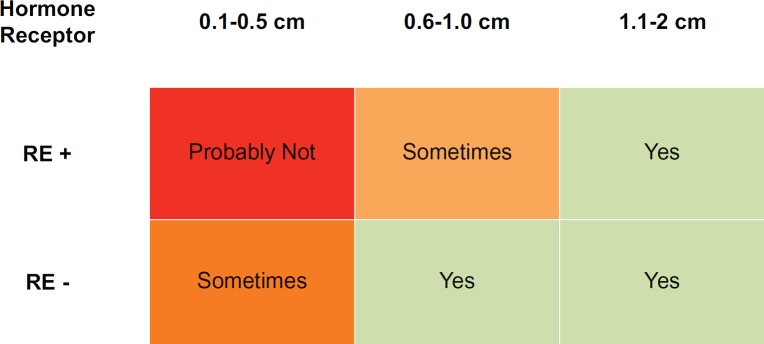
Suggestion for adjuvant therapy in Small Her-2+ Breast Cancer. Legend: HR+: Hormone receptor positive, HR-: Hormone receptor negative.